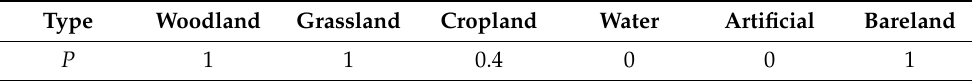
Table 2. Factor values of P